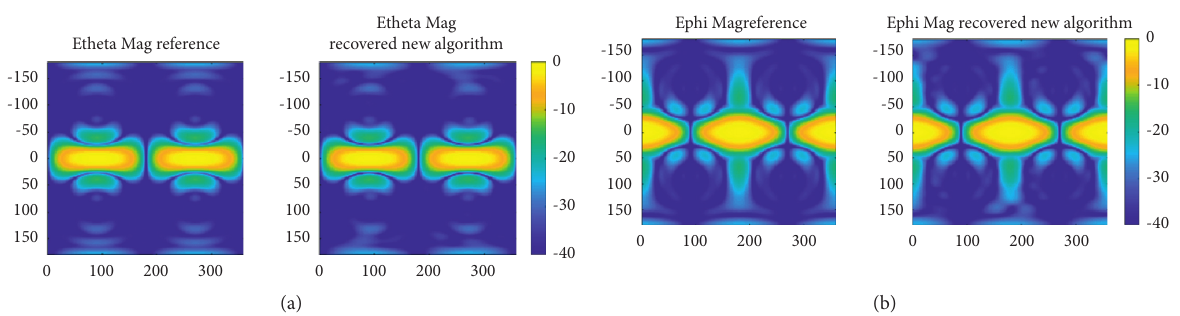
Figure 15: The reconstructed E